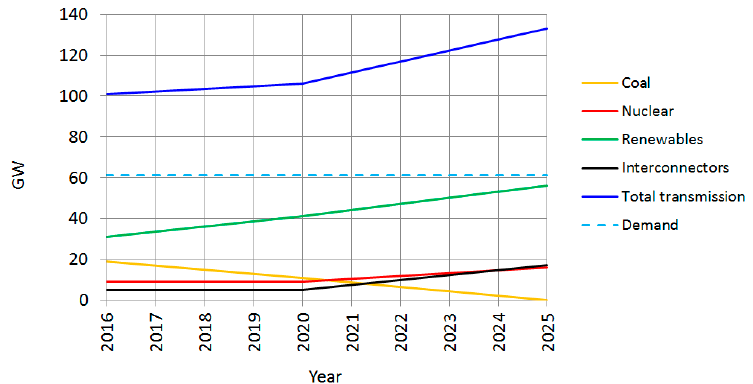
Figure 22. Current and projected installed power output (in GW) per generation technology, for the UK energy transmission system. Data extracted from [19,71].